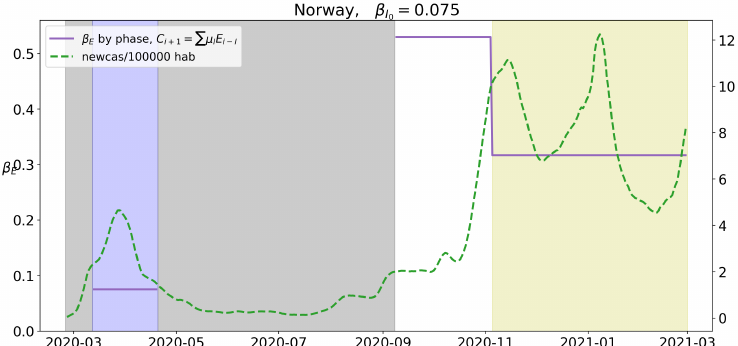
Figure 4. Value of β E for the different levels of lockdown. Blue background will correspond to Stage 1, red to Stage 2, yellow to Stage 3 and white to Stage 4. A green dotted line corresponds to the value of new cases per 100,000 hab.